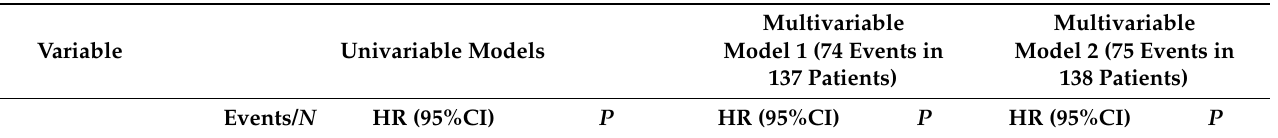
Table 2. Univariable and multivariable Cox regression models for progression-free survival: Effects of nutritional and other